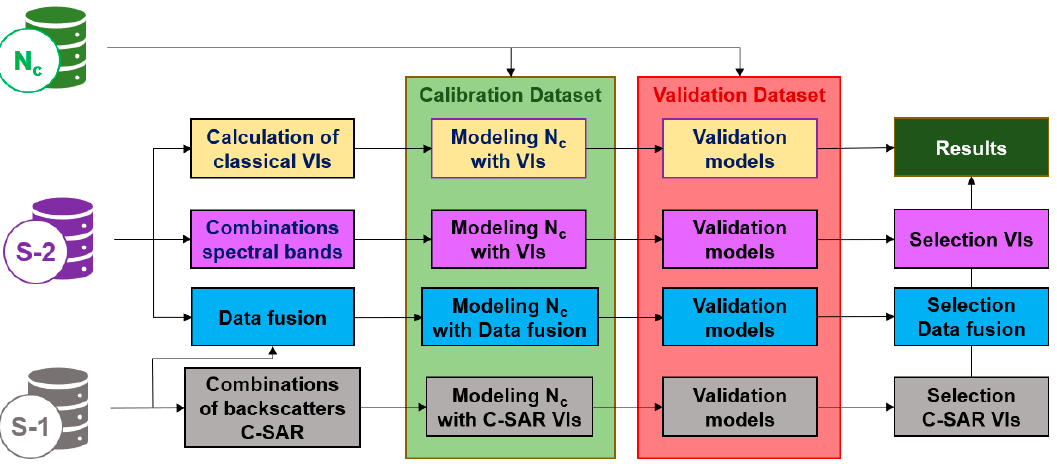
Figure 1. The conceptual framework for testing vegetation indices (VIs) derived from optical sensors, the combination of spectral bands, and integration of sensor data fusion to model corn nitrogen concentration (Nc). S-2: spectral bands from Sentinel-2; S-1: C-SAR data from Sentinel-1.